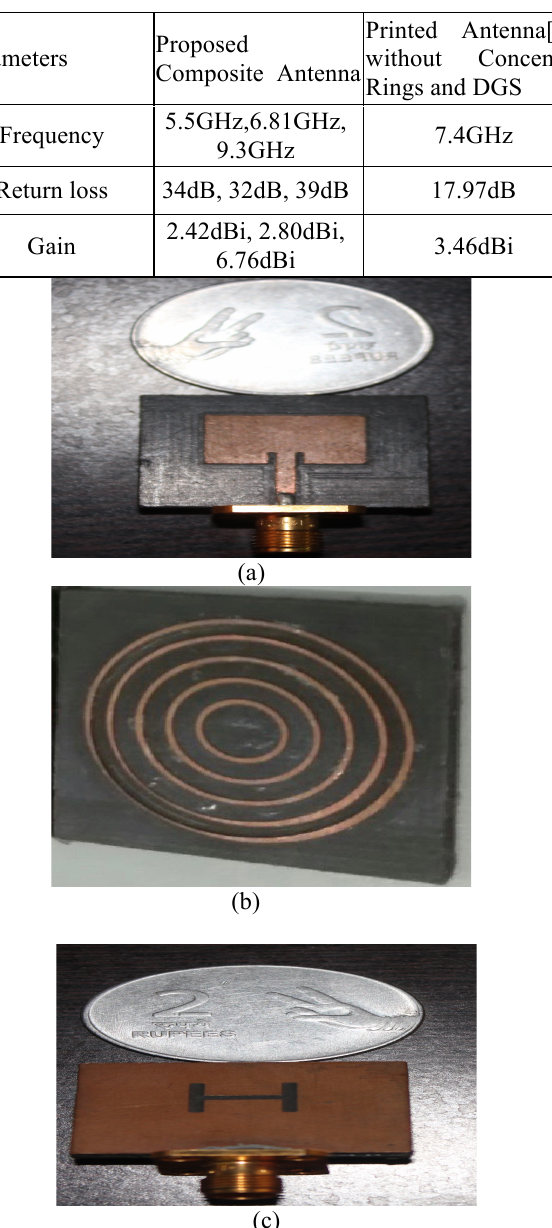
Table 2: Results of Proposed Antenna and reference